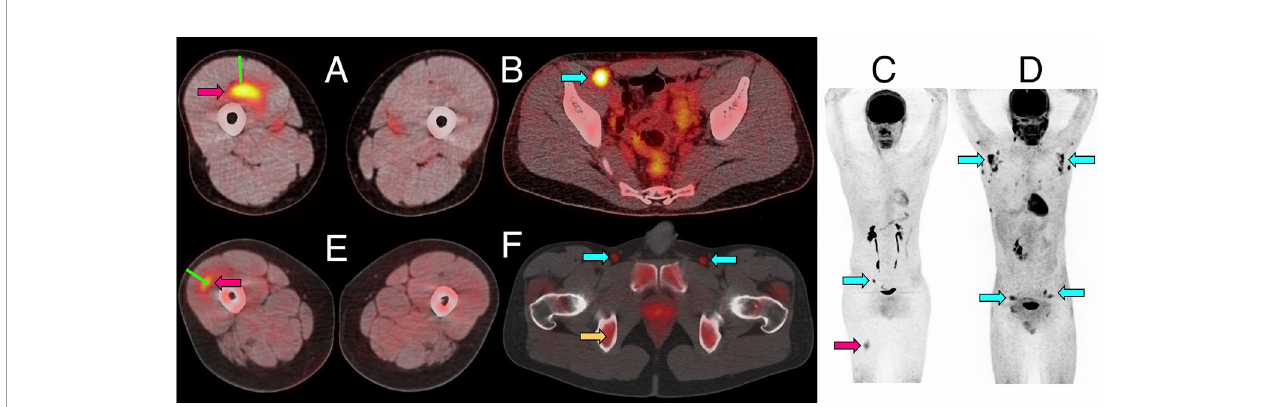
FIGURE 1 | Representative PET/CT images of intramuscular injection site and draining lymph nodes. (A – C) Fused 18 F-FDG PET/CT images (linear scale) from one participant 5 days after immunization with 4CMenB, demonstrating increased activity at right anterior thigh intramuscular injection site ( A , red arrow) and right external iliac lymph node ( B , cyan arrow); whole body PET scan anterior view (C) demonstrating level of injection site (red arrow) and activated lymph node (cyan arrow). (D) Whole body 18 F-FDG PET scan anterior view demonstrating disseminated axillary and pelvic lymph node activity (cyan arrows) 1 day after immunization with ATIV. (E , F) Fused 11 C-PBR28-PET/CT images (linear scale) from two participants immunized with 4CMenB demonstrating increased 11 C-PBR28 binding in right thigh injection site ( E : red arrow, day +3); and right and left deep inguinal lymph nodes ( F : cyan arrows, day +7, right thigh injected). Increased bone marrow binding of 11 C-PBR28 also visible ( F : yellow arrow). Green bars (A , E) indicate length of immunization needle, actual track unknown. Diffuse uptake of 18 F-FDG can be seen in bowel (B) , and for both radionucleotides in urinary collecting system and bladder (B – D, F) .